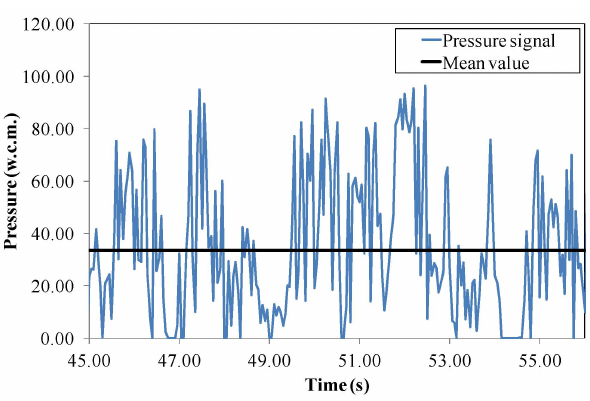
Figure 9. Pressure signal on the stagnation point for the free surface weir calculated with FLOW-3D, considering a water cushion Y 0 = 2 m.